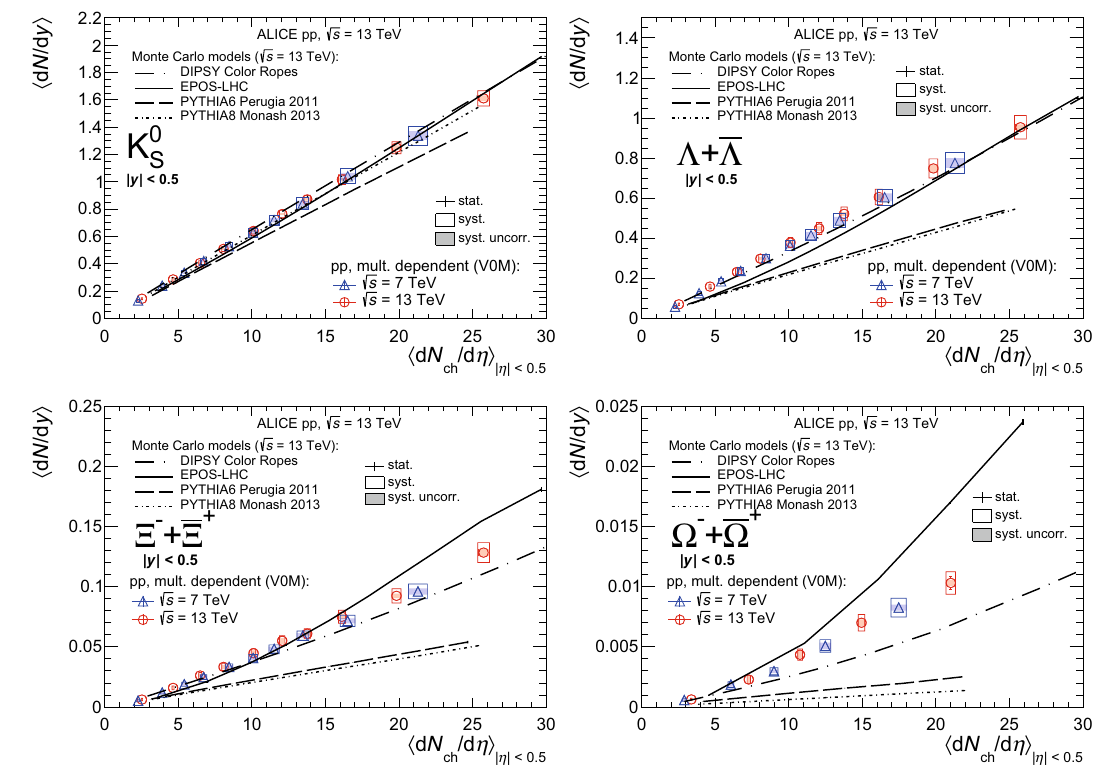
Fig. 14 Integrated yields of K 0 , (cid:3) , (cid:4) , and (cid:5) as a function of d N ch / d η boxes, respectively. Shadowed boxes represent uncertainties uncorre- √ S s = 7 and 13 TeV. Statisti- in V0M multiplicity event classes at lated across multiplicity. The results are compared to predictions from several Monte Carlo cal and systematic uncertainties are shown by error bars and empty